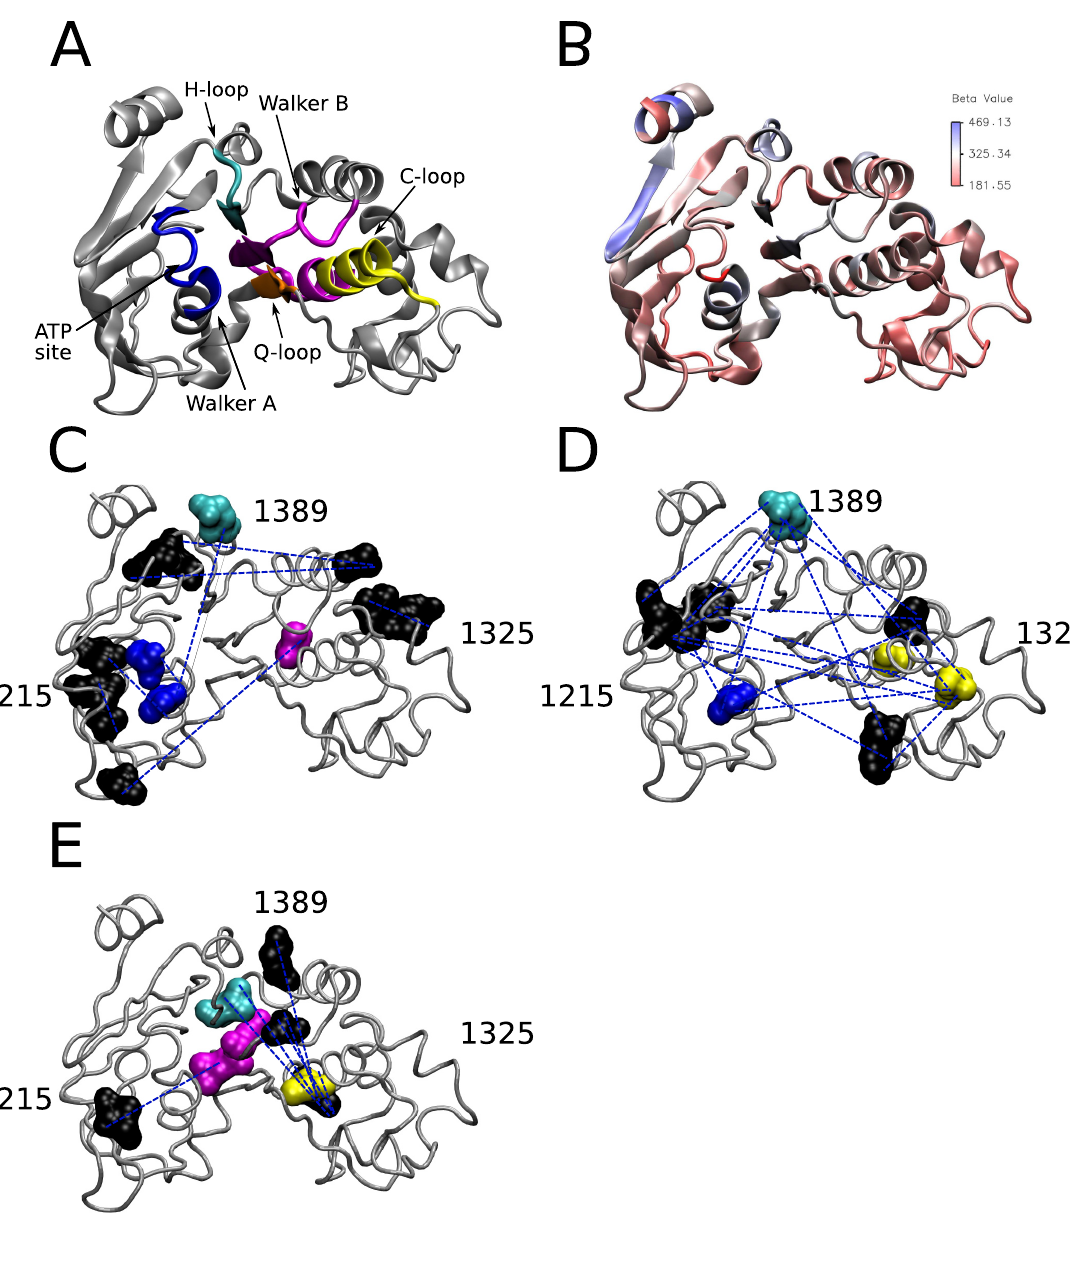
Fig 9. CF mutations alter predicted coupling between α -helical and β -subdomains of NBD2. (A) Cryo-EM Structure of NBD2 residues 1207–1436 (PDB:5UAK) with Walker A (blue), Walker B (magenta), Q-loop (orange), ABC signature C-loop (yellow), and H-loop (cyan) labeled (B) NBD2 structure with residues color coded to reflect corresponding B-Factor values (C) NBD2 wildtype (full MSA) coupled residues from Fig 3D mapped onto NBD2 structure (D) Perturbation S1251T coupled residues from Fig 4D mapped onto NBD2 structure (E) Perturbation S1235R coupled residues from Fig 5D mapped onto NBD2 structure. Coupled residues colored to Walker A, Walker B, Q- loop, H-loop, and C-loop motifs from (A) except for black residues outside aforementioned motifs. Dotted blue lines indicate coupling between residues. Structures visualized using VMD [55] and rendered using Tachyon